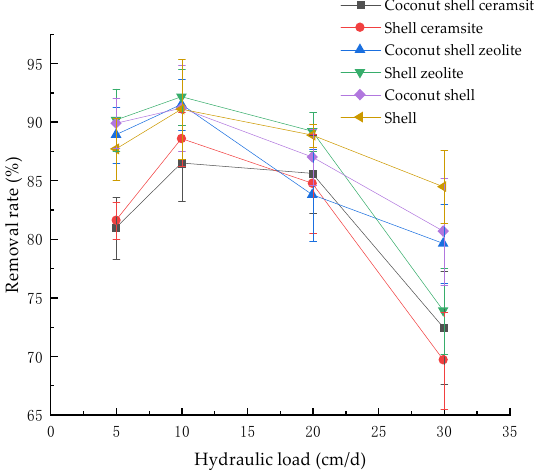
Figure 7. Removal effect of COD in biochar-constructed wetland.